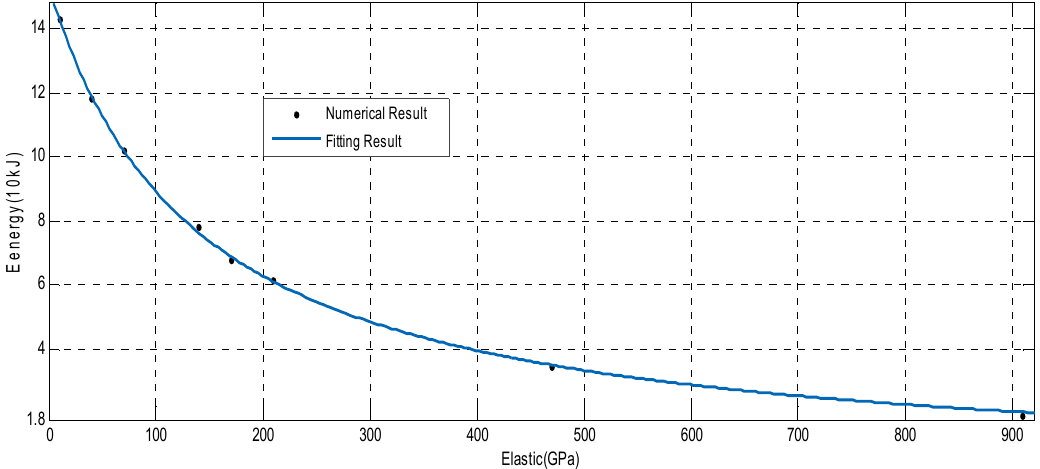
Figure 34. The plot of energy vs. elastic modulus with t = 0.01 m, detonation position, x = 0, z = 0.